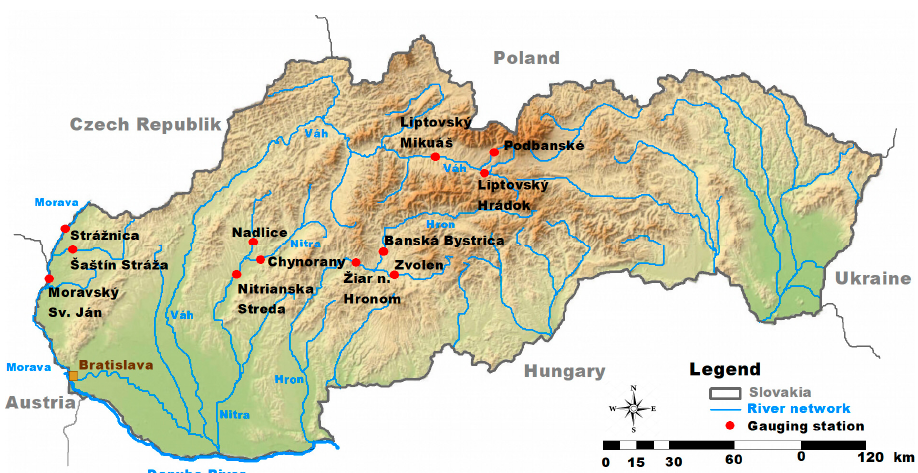
Figure 1. Selected river network and gauging stations. Table 1. Selected mainstreams and their tributaries, stations, analyzed periods, annual maximum discharge, river kilometer, and basin area.